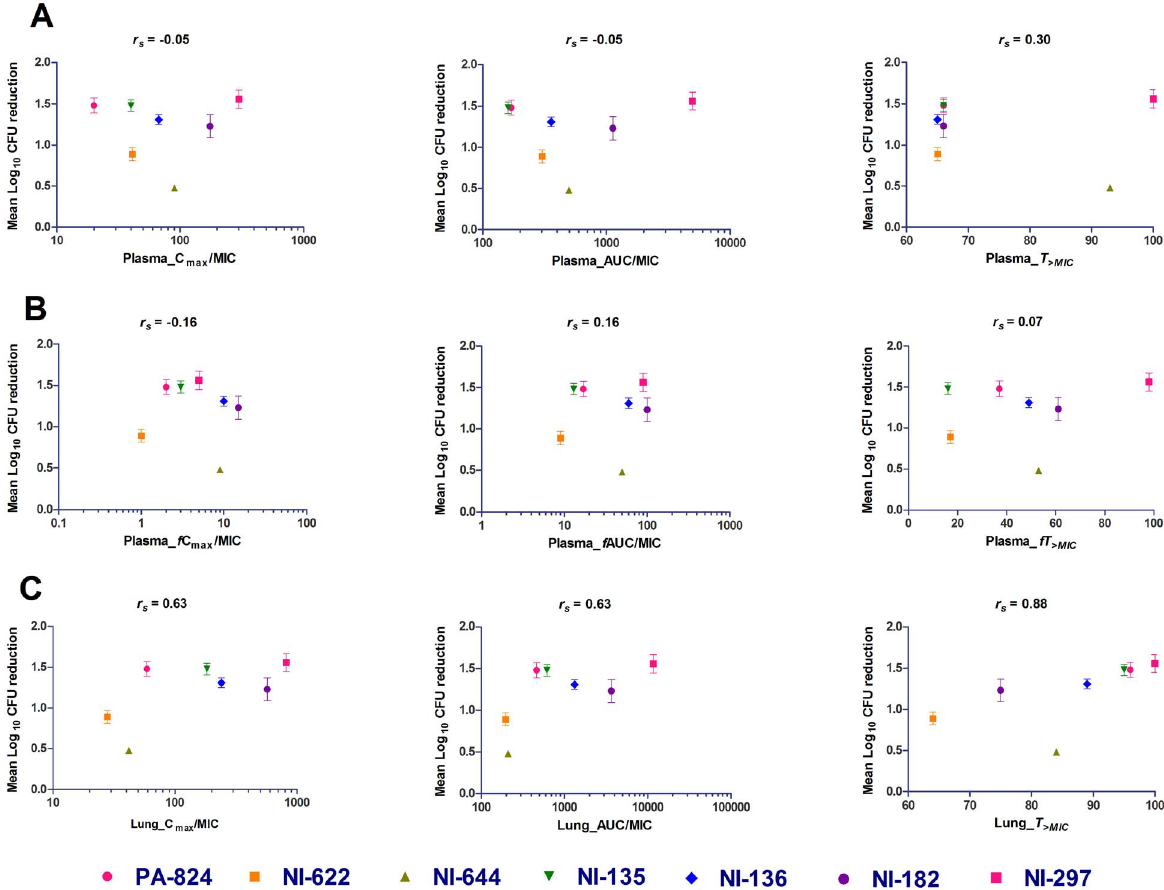
Figure 3. Correlation of PK-PD indices (C max /MIC, AUC/MIC and T . MIC ) with invivo efficacy in mice for bicyclic 4-nitroimidazole analogs in total plasma concentration (A), free plasma concentration (B) and total lung concentration (C). Each data point represents D Mean log lung CFU reduction compared to untreated controls (mean value 6 SEM from 5 animals). r s is the Spearman’s rank correlations coefficient.